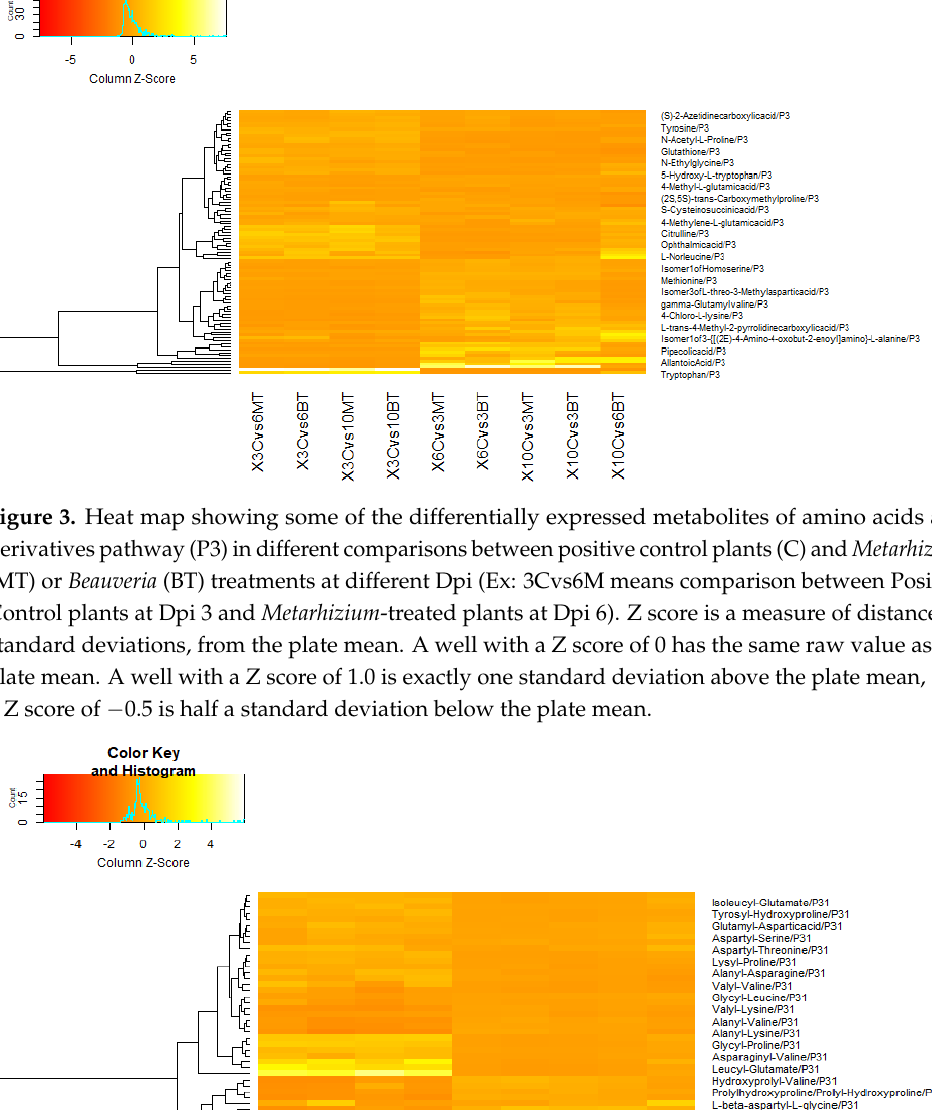
Figure 5. Heat map showing some of the differentially expressed metabolites of Cysteine and Me- thionine metabolism (P26) and Glycine, Serine, and Threonine metabolism (P40) pathways in dif- ferent comparisons between positive control plants (C) and Metarhizium (MT) or Beauveria (BT) treat- ments at different Dpi. Z score is a measure of distance, in standard deviations, from the plate mean. A well with a Z score of 0 has the same raw value as the plate mean. A well with a Z score of 1.0 is exactly one standard deviation above the plate mean and a Z score of −0.5 is half a standard devia- tion below the plate mean.